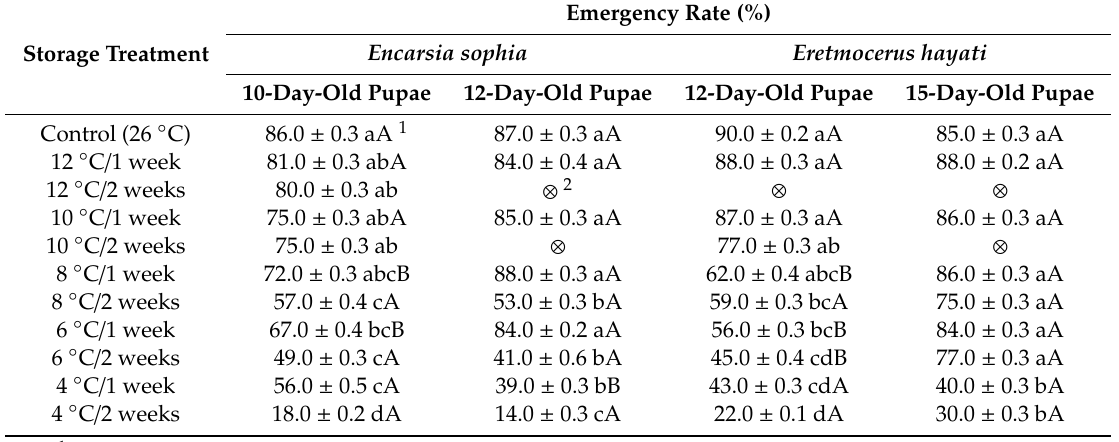
Table 1. Emergence rates of Encarsia sophia and Eretmocerus hayati after storage at di ff erent pupal ages exposed to di ff erent temperatures and duration. Data are means ± standard error